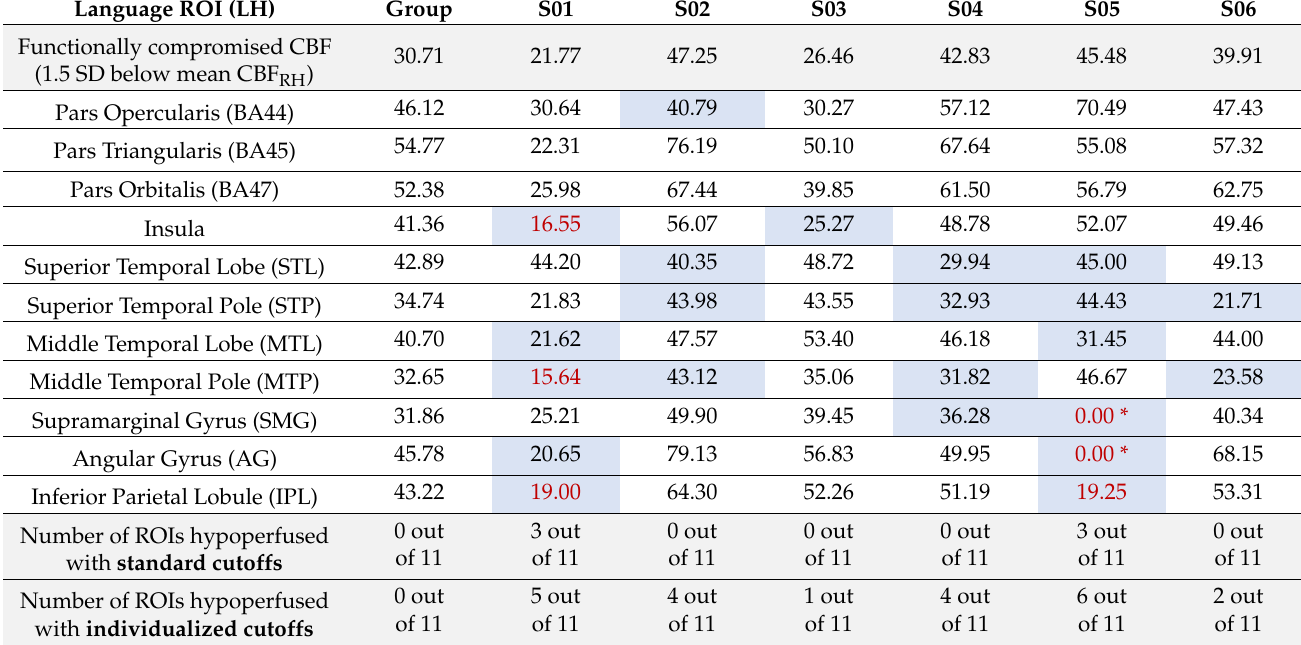
Table A4. A comparison of hypoperfused ROIs based on individualized (blue shading) and standard (red font) threshold values at both the group and individual level. The numbers in the table represent mean CBF (mL/100 g tissue/min) in that left hemisphere (LH) ROI. * values of 0 likely reflect a small number of voxels that were not captured in the original lesion mask due to their proximity to large